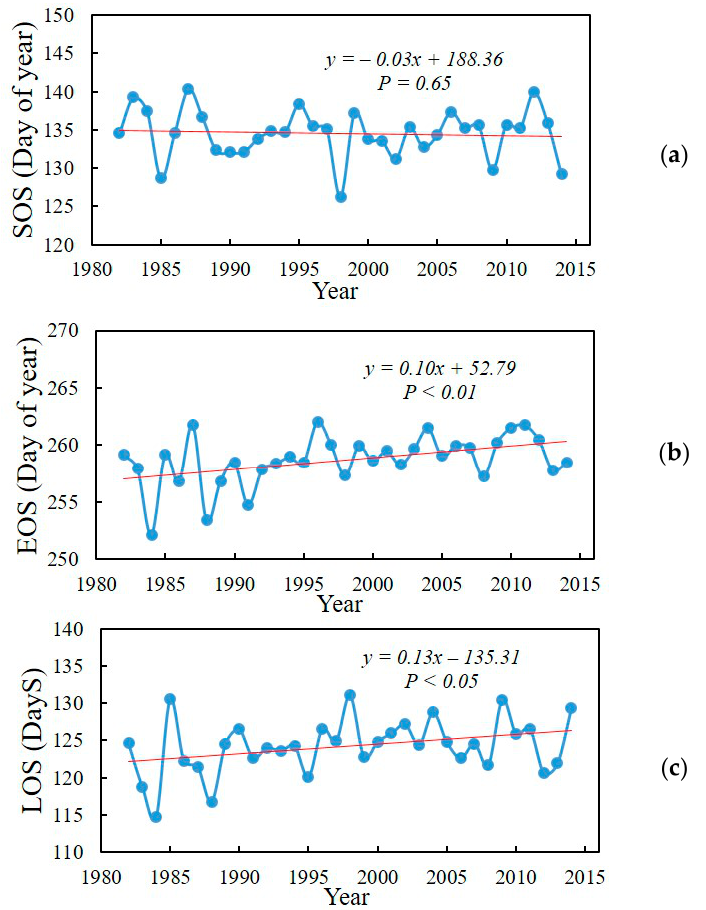
Figure 4. Interannual variations in (a) SOS, (b) EOS, and (c) LOS in northeast China during